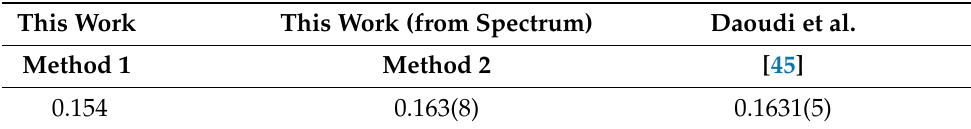
Table 3. K β /K α intensity